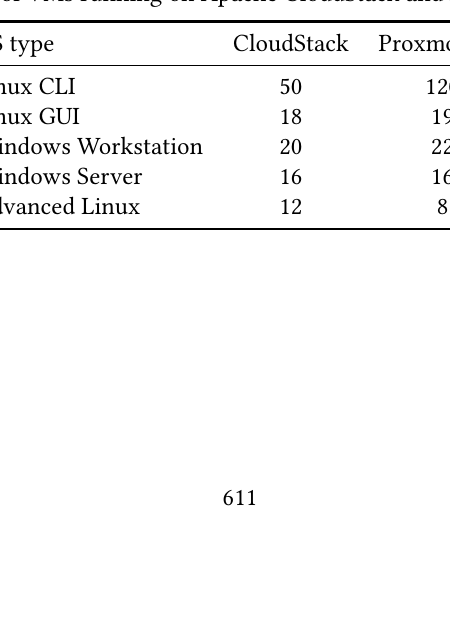
Comparison of the number of VMs running on Apache CloudStack and Proxmox VE